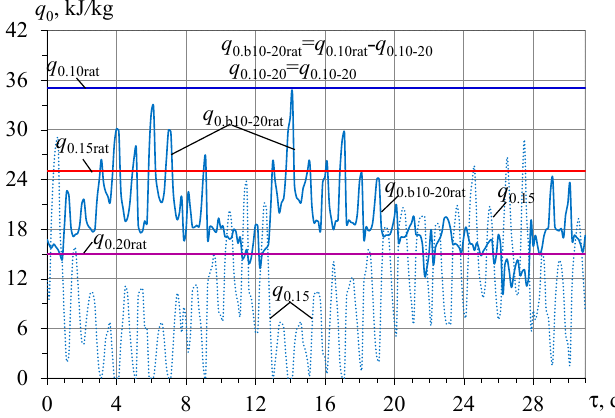
Figure 4. Current values of specific thermal load q 0.15 for cooling ambient air to t a 2 = 15 °C, available design specific boost cooling capacity q 0.b10-20rat for cooling ambient air to t a 2 = 20 °C: q 0.b10-20rat = q 0.10rat − q 0.10-20 , q 0.10-20 = q 0.10 − q 0.20 .